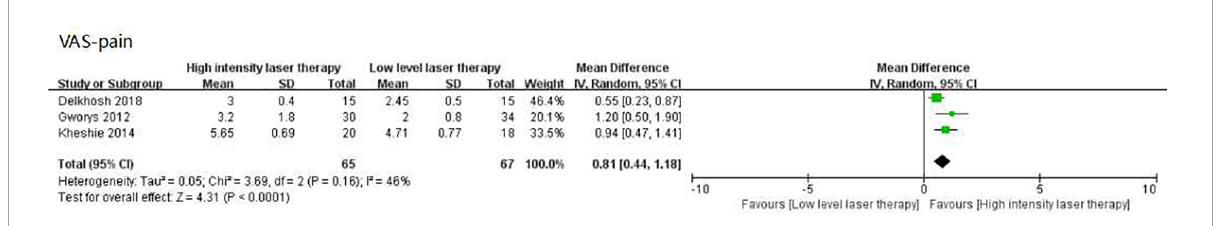
FIGURE4 Forest plot of the visual analog scale (VAS)-pain in high intensity laser therapy (HILT) vs. Low level laser therapy.